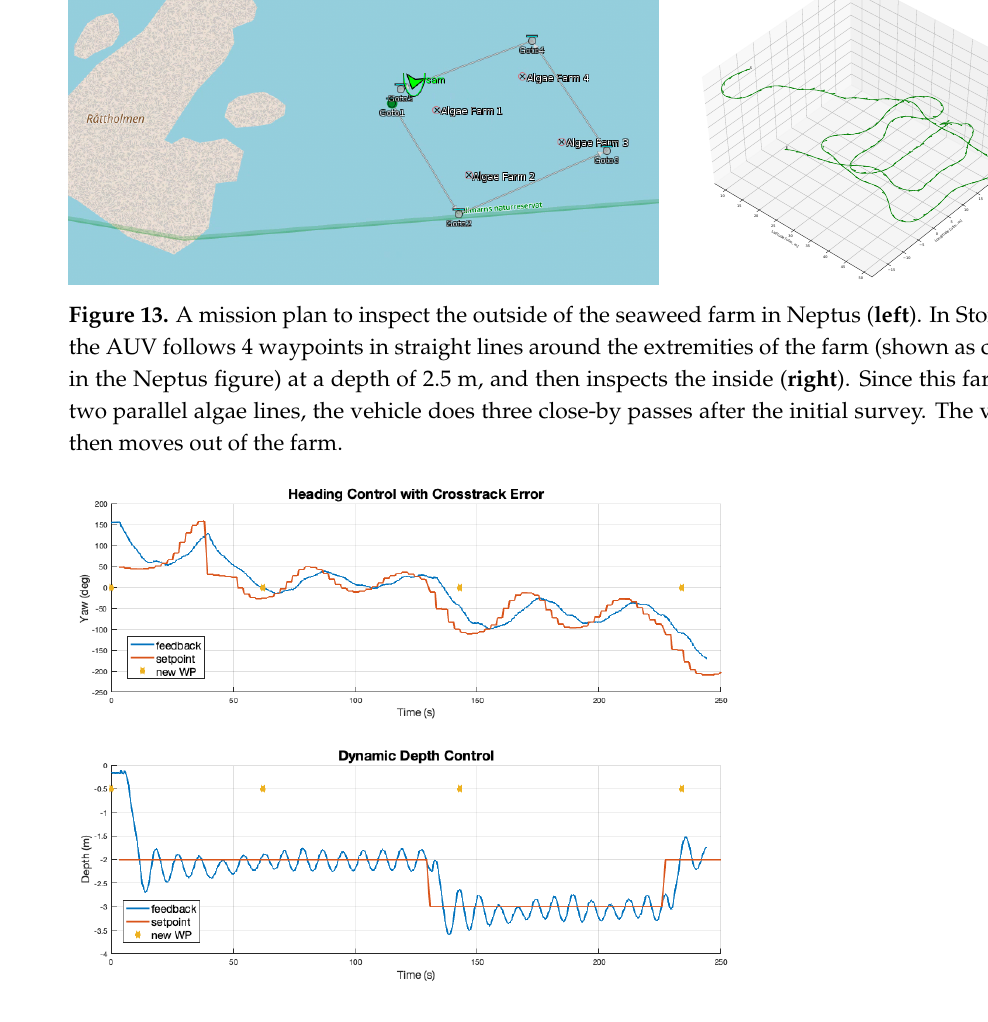
Figure 14. The top plot shows how our PID control follows a yaw command in the simulation while the bottom shows depth control. The orange plots show the set point sent to the actuation controller while the blue is the estimated values used for the feedback to the set-point PID controller. The yaw set-point is computed using the presented LOS guidance law based on cross-track error. The gold stars show points where the way-point from the planner